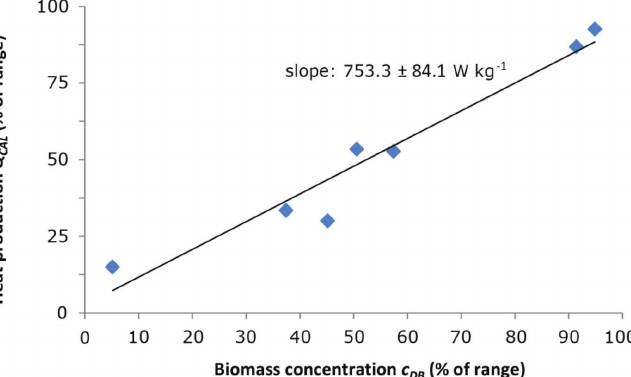
Fig. 7 – Upper envelope of the data on the biomass heat pro- duction resulting in the average value of the specific biomass heat production equal to 753.3 ± 84.1 W kg –1 of dry biomass